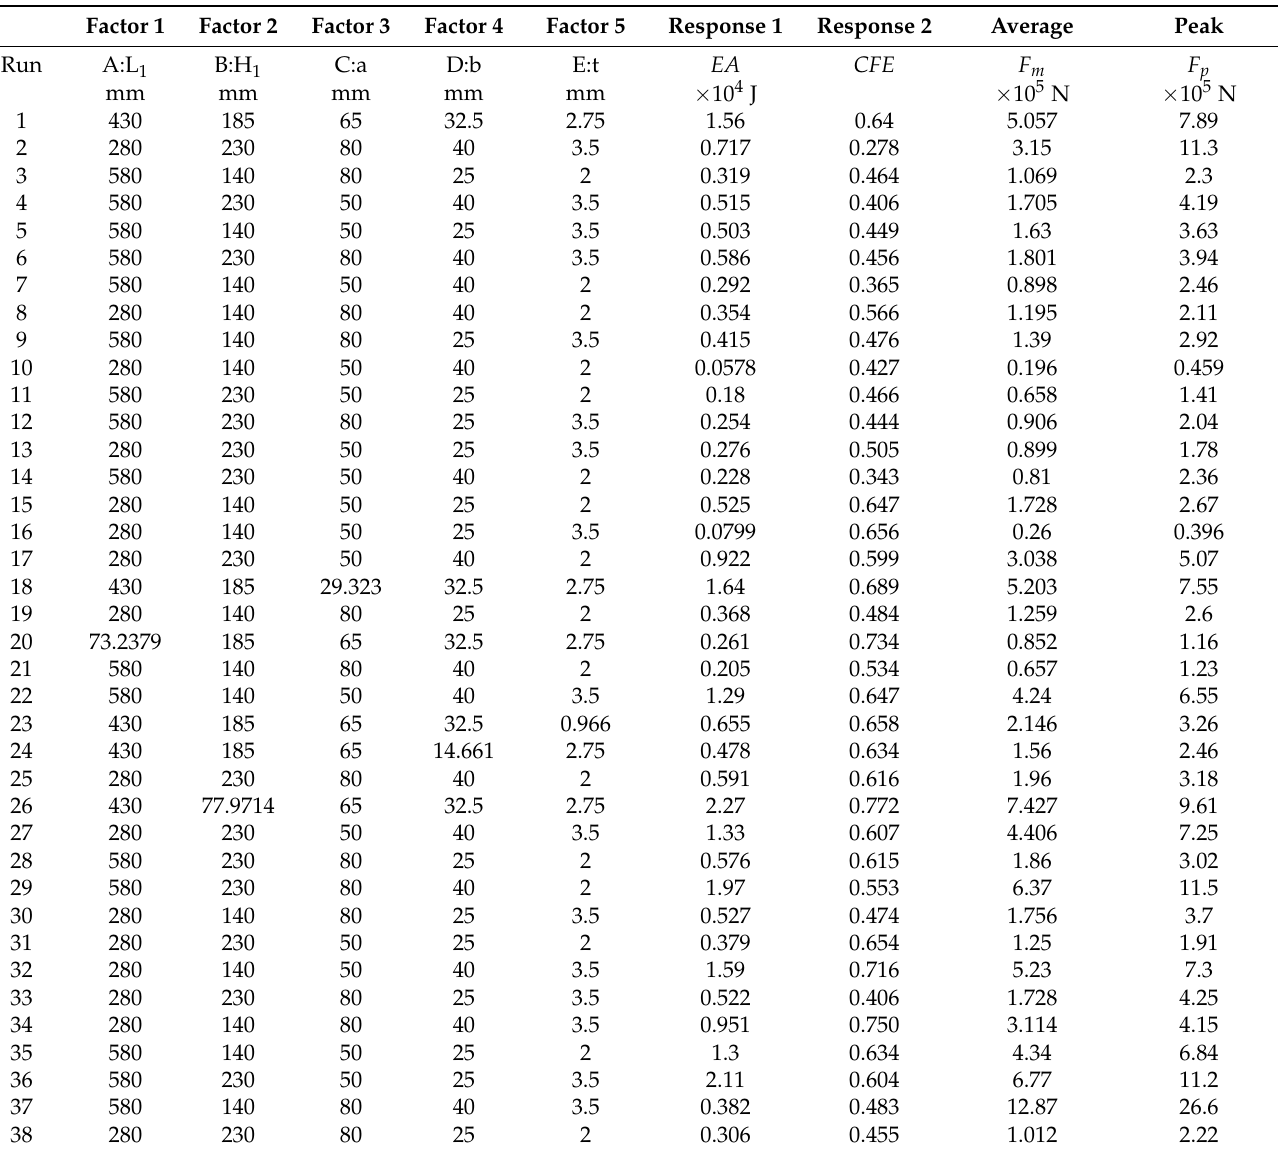
Table 2. Parametric structural design